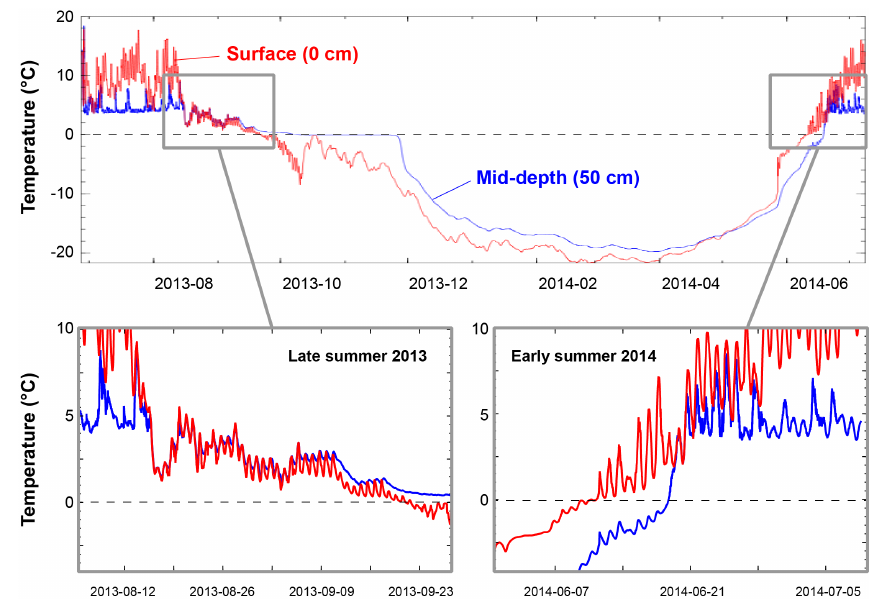
Figure 4. Water temperature at two depths (surface = 0cm; mid-depth = 50cm) in trough pond BYL27 over 1year (27 June 2013 to 8 July 2014), showing extended stratification and rare mixing events (lower panels) during the summer.